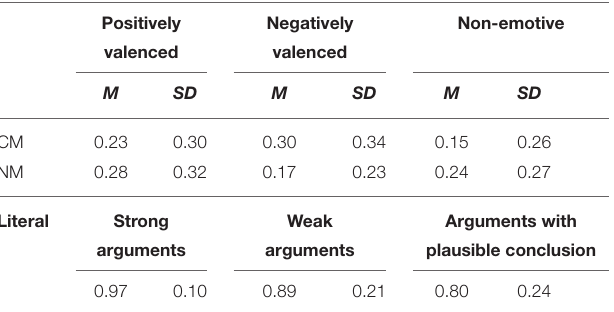
TABLE 8 | Mean (M) and standard deviation (SD) values of correct answers for each middle term condition (Experiment